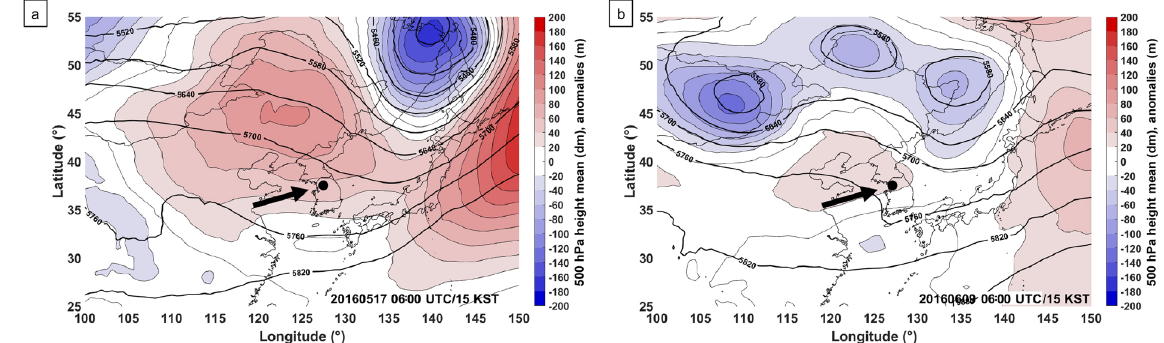
Figure 3. MERRA-2 500hPa geopotential heights and anomalies for (a) 17 May and (b) 9 June 2016 at 21:00KST (TRF marked in black dot/arrow). Table 1. Measurement species divided by each platform used throughout the case